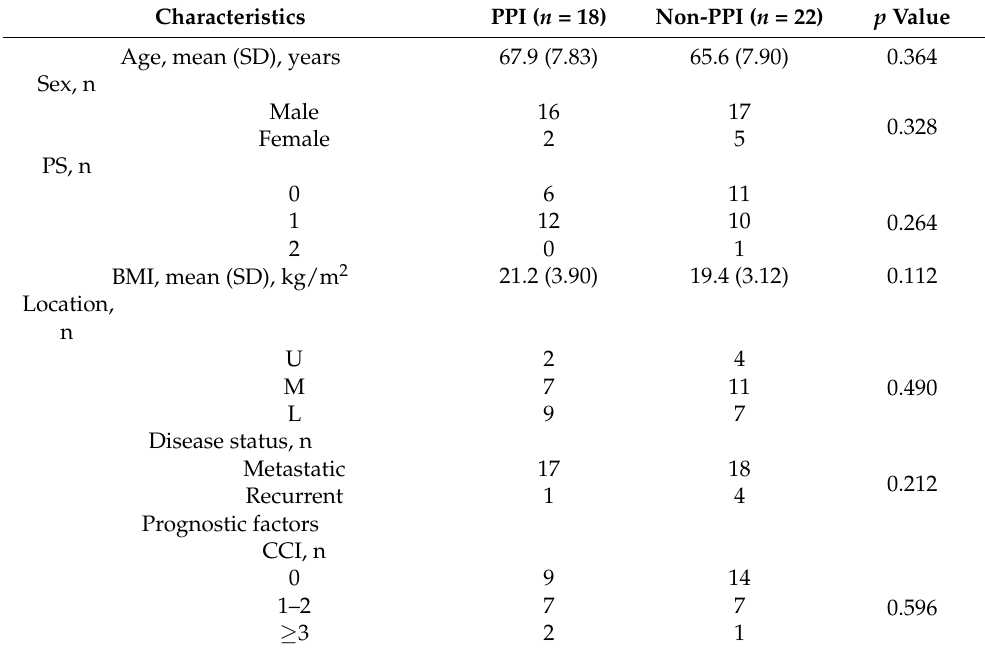
Table 1. Baseline characteristics of esophageal cancer patients taking PPIs vs. esophageal cancer patients not taking PPIs .